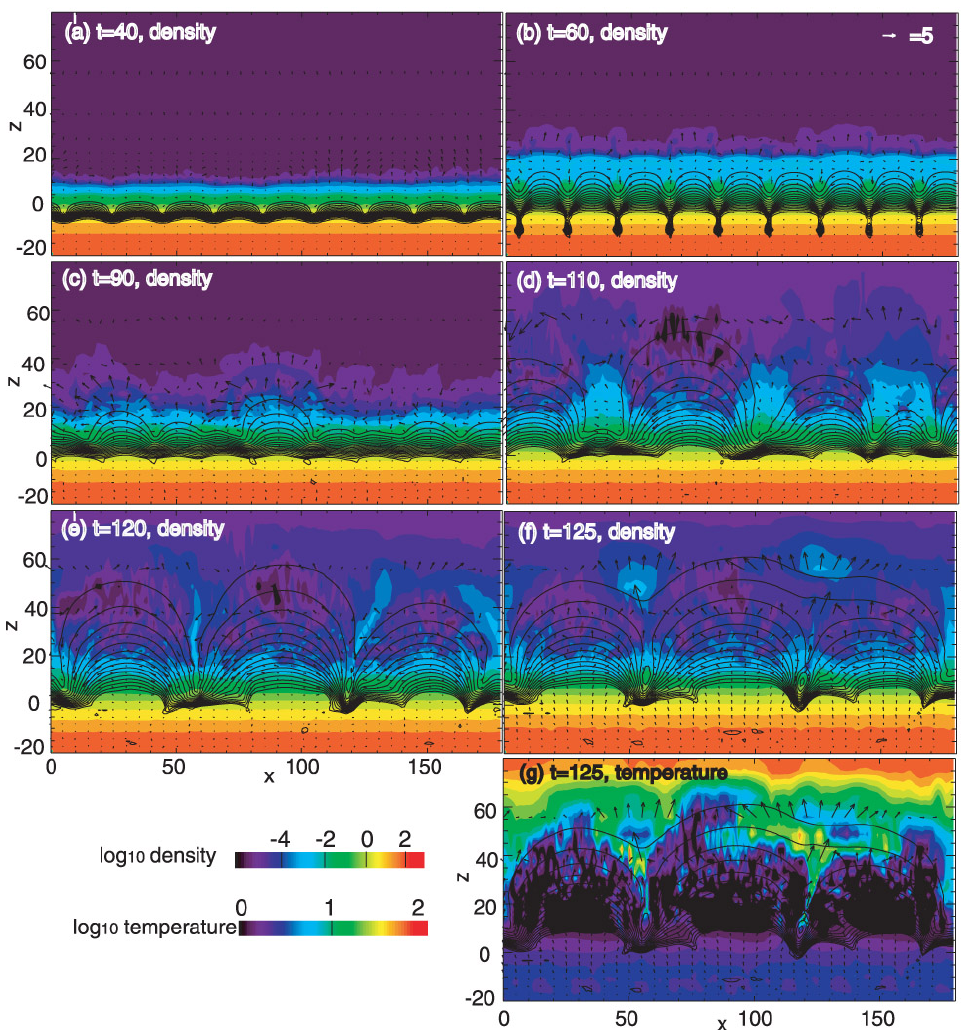
Figure 52: 2D simulation of hierarchical evolution of multiple emerging loops. Image reproduced with permission from Isobe et al. (2007b), copyright by